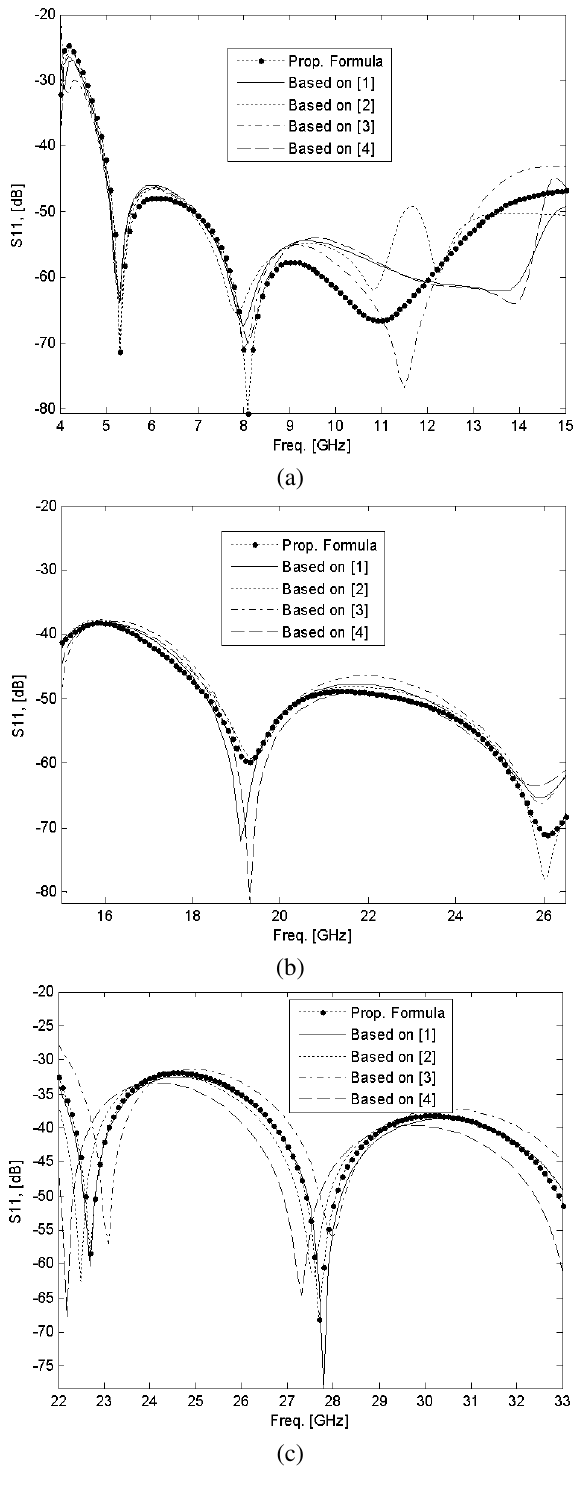
Figure 5: Reflection coefficient of a SIW obtained by HFSS for: (a) (cid:15) r = 2 . 33 , Weq=14.97 mm, p=1 mm, d=0.65 mm, h=0.508 mm. (b) (cid:15) r = 3 . 5 , Weq=6.86 mm, p=1 mm, d=0.8 mm, h=0.508 mm. (c) (cid:15) r = 5 . 7 , Weq=2.50 mm, p=1 mm, d=0.8 mm, h=0.508 mm.